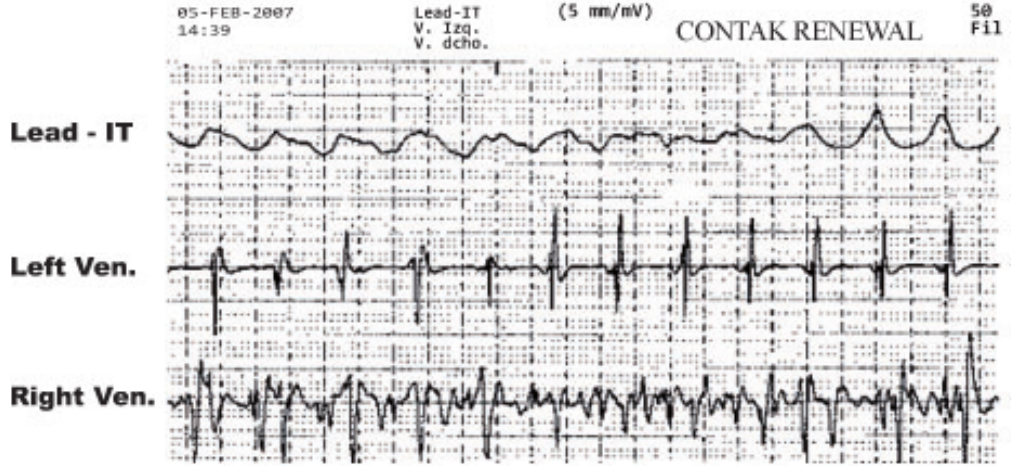
Figure 3. Example of recorded and stored